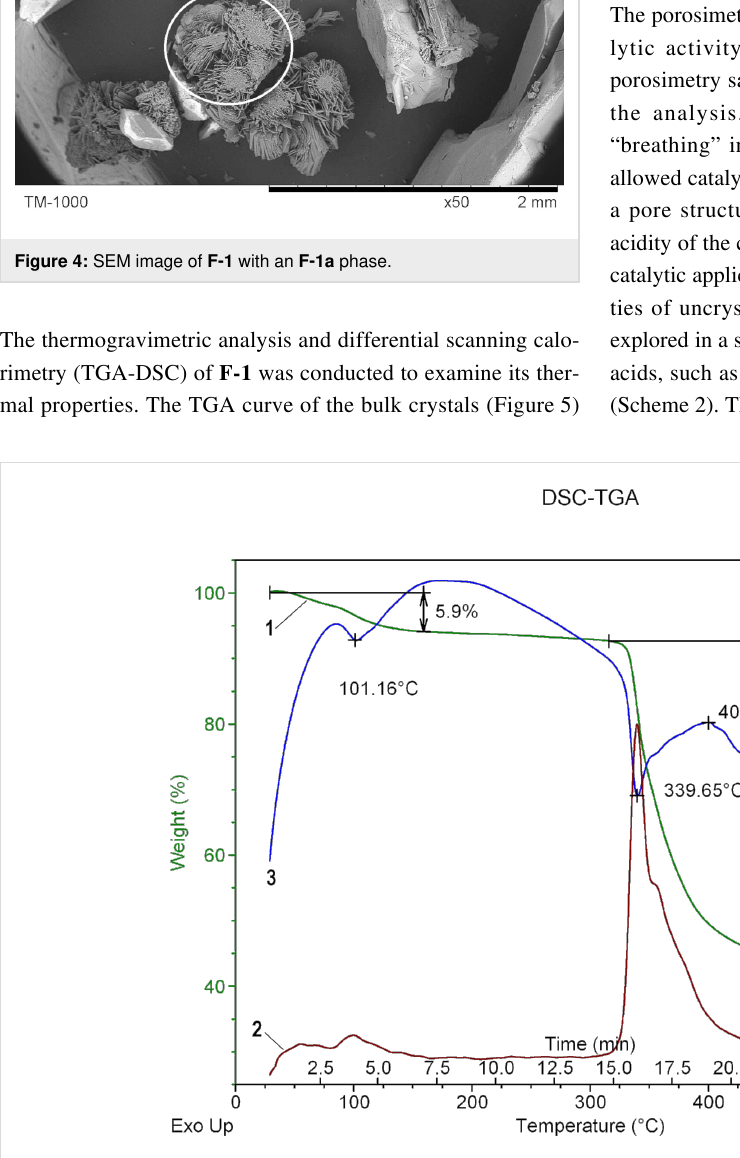
Figure 5: TGA-DSC analysis of a sample of F-1 . The TGA plot is shown in green, the DSC curve is shown in blue, and the first differential of the DSC curve is shown in red.